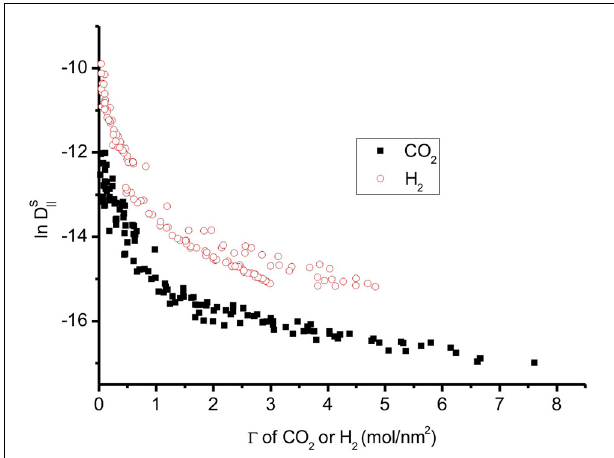
FIGURE 11 | Natural logarithm of all self-diffusion coefficients vs . adsorption of CO 2 and H 2 . H 2 has higher diffusion coefficients than CO 2